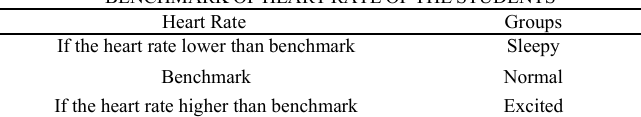
TABLE1 BENCHMARK OF HEART RATE OF THE